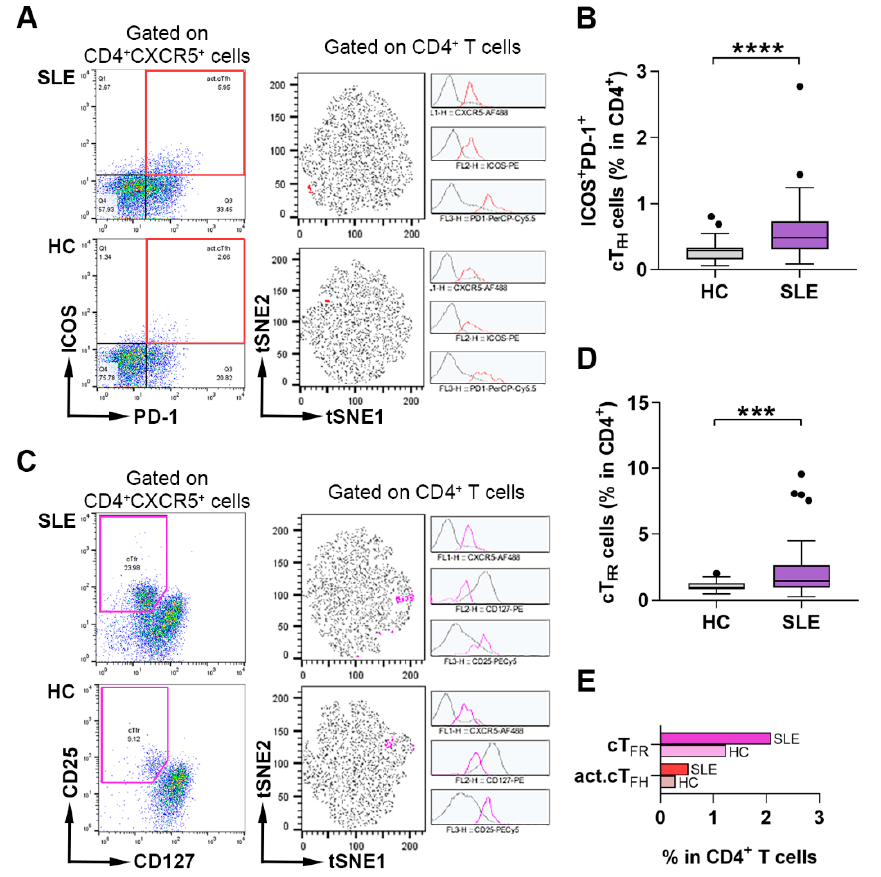
Figure 1. The distribution of activated cT FH and T FR cells in lupus patients and healthy individuals. Peripheral blood mononuclear cells (PBMCs) were isolated from 48 SLE patients and 36 healthy controls (HC) were then stained with fluorochrome-conjugated monoclonal antibodies, as described in Materials and Methods. The proportions of peripheral activated (act.) cT FH cells and cT FR cells were quantified as their percentage within CD4 + lymphocytes. ( A ) Representative dot plots from an active lupus patient and HC show the identification of activated cT FH cells using ICOS and PD-1. Merged tSNE plots incorporating 30,000 CD4 + T cells from the corresponding lupus patient and healthy control show the act.cT FH cluster identified by tSNE clustering analysis (red color represents act.cT FH ). Histograms show the expression of markers used to identify act.cT FH cells. ( B ) Percentages of act.cT FH cells. ( C ) Representative dot plots from an active SLE patient and HC show the identification of cT FR cells by CD127 and CD25. Merged tSNE plots incorporating 30,000 CD4 + T cells from the corresponding lupus patient and healthy control show the cT FR cluster identified by t-SNE clustering analysis (magenta color represents cT FR ). Histograms show the expression of markers used to identify cT FR cells. ( D ) Percentages of cT FR cells. ( E ) The proportions of act.cT FH and cT FR clusters among CD4 + T cells were indicated by the horizontal bars. Mann–Whitney nonparametric test was used ( C , E ). Box plots represent the interquartile range (IQR) with a line in the middle as the median. Statistically significant differences are indicated by *** p < 0.001; **** p < 0.0001.